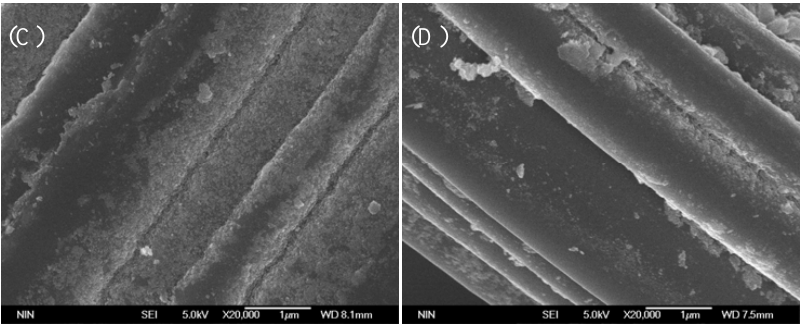
Figure 10. Scan Electronic Microscope patterns of carbon cloth ( A ) and Fe@CC of fresh prepared with hydro-thermal reaction ( B ), after 5 times reaction ( C ), and after 11 times reaction ( D ).